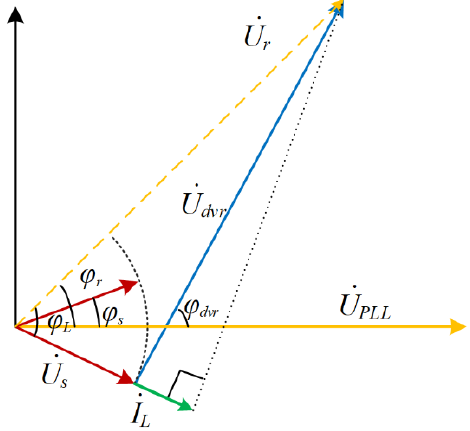
Figure 6. Minimized compensation phasor diagram of non-zero active energy.